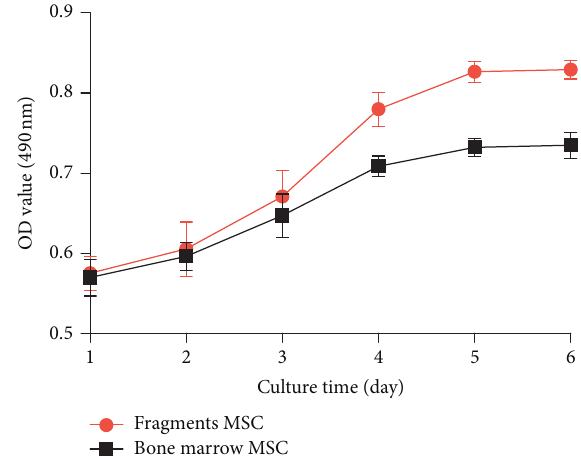
Figure 2: Cell growth curves of the first passage from cultured bone marrow and bone fragments. ∗ 𝑃 < 0.05 , compared with bone marrow MSC at the same